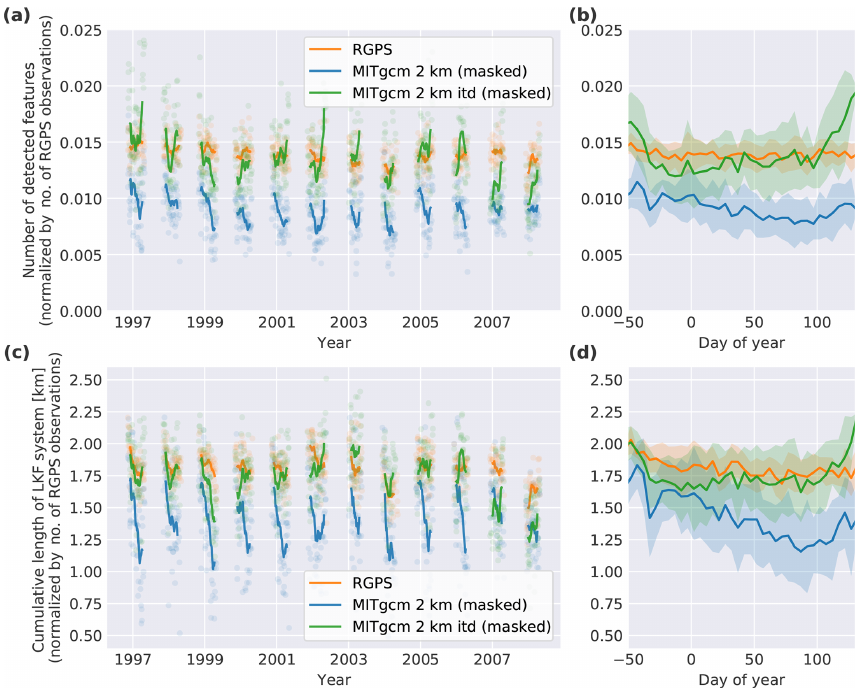
Figure 4. (a) The number of LKFs detected for the entire observing period (1996 to 2008). The lines are running means with a window size of 17d of the individual daily numbers represented by the light-colored dots. (b) Seasonality of the number of LKFs. The lines are running means with a window size of 5d. The shaded areas show the standard deviation of the individual years. (c) The same as panel (a) but showing the cumulative length of the system of all LKFs, defined as the sum of all LKF lengths in one record. (d) The seasonal cycle of the cumulative length of the LKF system. For the analysis presented in this figure the LKF datasets of both simulations are filtered for RGPS